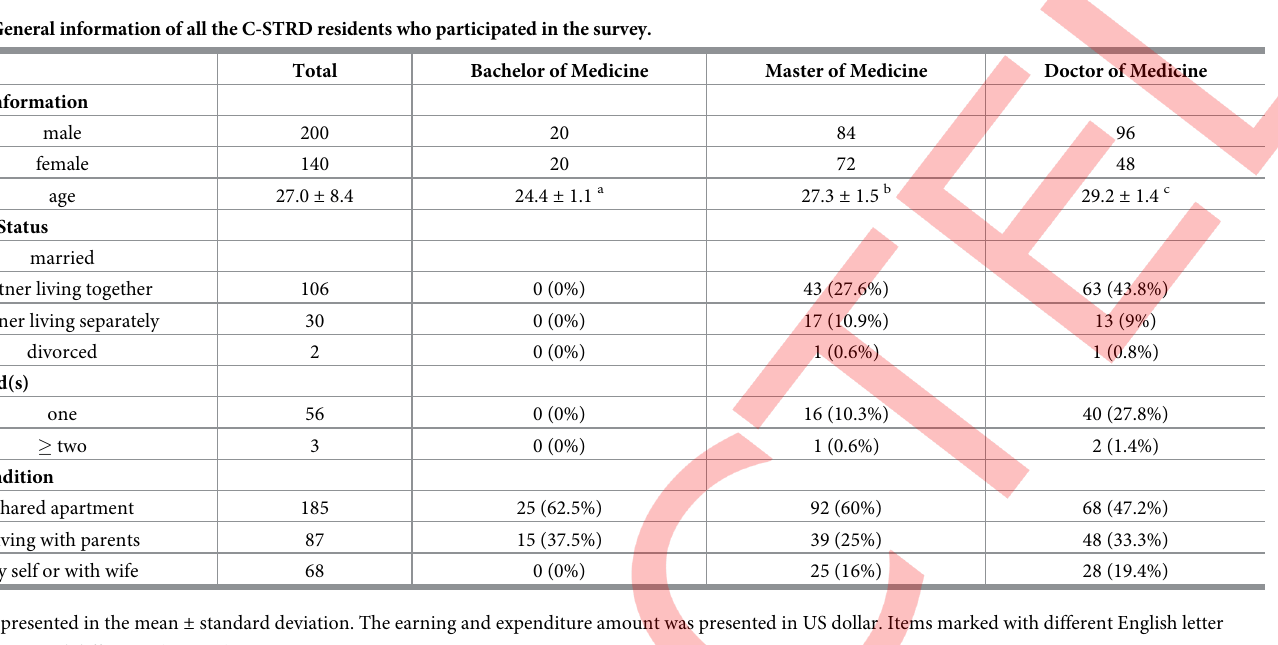
(Table 2) and financial status among participants with different educational degree. The one- way ANOVA was applied to the Total Score comparison (Table 3) while the one-way ANOVA on ranks test (a.k.a. Kruskal-Wallis test), following the post hoc test, was used to check for detailed difference of stressor fact (Table 3) and workload among participants with different educational degree. P value < 0.05 was considered statistically significant for the entire study, except for Table 3, the significant level of the Kruskal-Wallis test was set for 0.01.